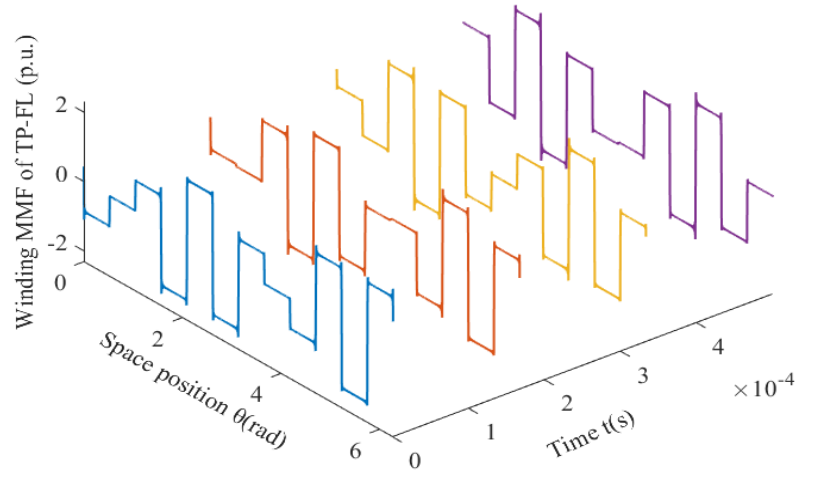
Figure 9. For 12-slot/10-pole TP-FL winding, resultant winding MMF changes with time and space. Star graph and winding layout of a 12-slot/10-pole double-three-phase four-layer (DTP-FL) winding are shown in Figure 10. Coil vector and winding distribution of DTP-FL winding are given in Figure 10a,b, respectively. It can be seen from the winding distribution (Figure 10b) that DTP-FL winding is composed of two groups of three-phase double layer with space shift 30